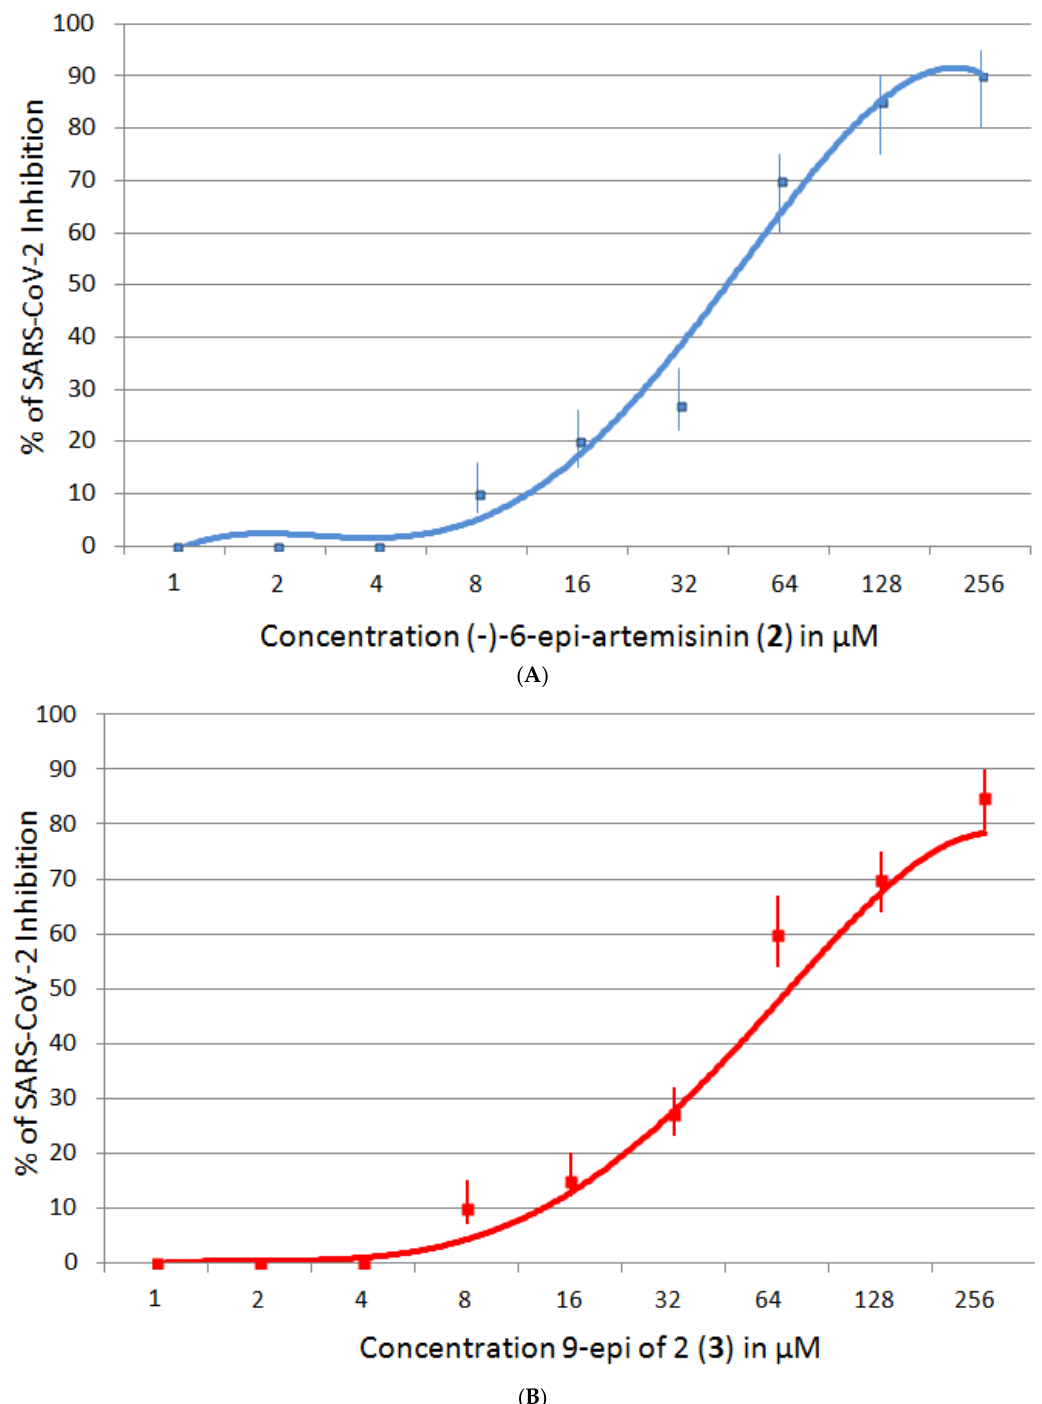
Figure 8. SARS-CoV-2 Inhibitory assay of ( − )-6-epi-artemisinin ( 2 ) ( A ) with EC 50 = 49 ± 0.32 µ M and SARS-CoV-2 inhibitory assay of 9 epimer of 2 ( 3 ) ( B ) with EC 50 = 54 ± 0.27 µ